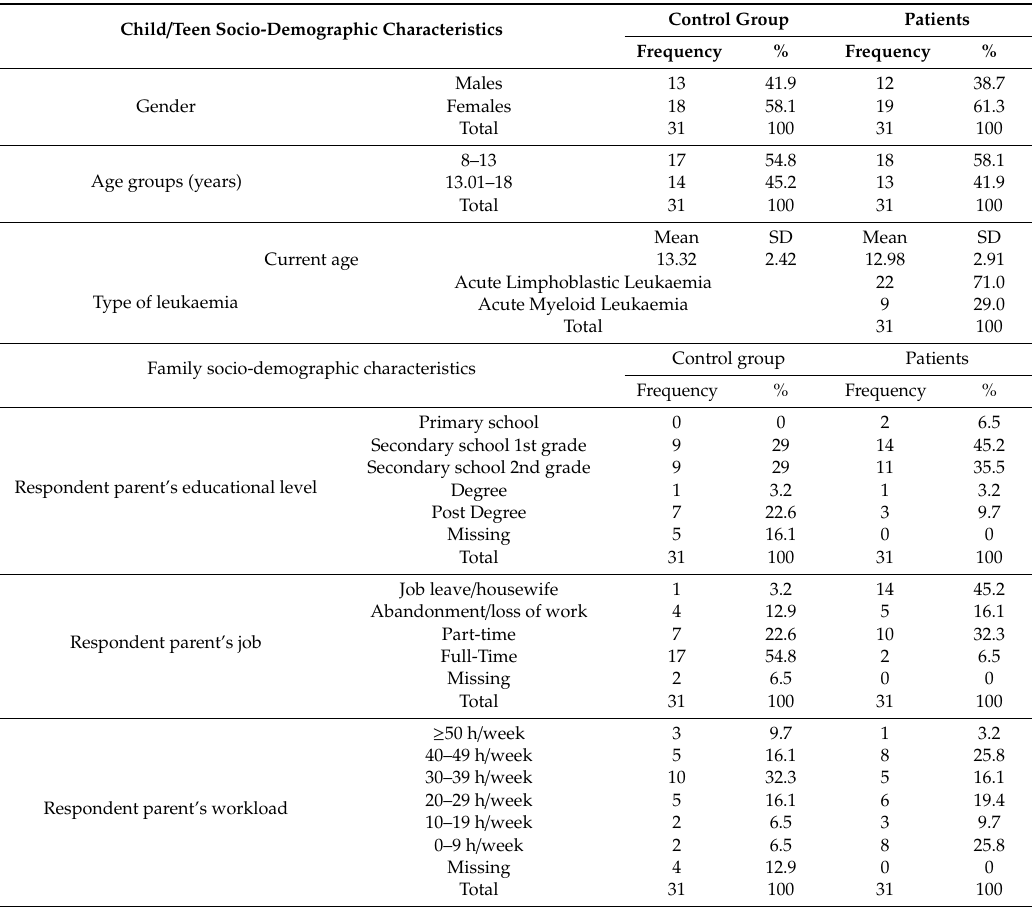
Table 1. Socio-demographic characteristics of patients / families and healthy controls / families at 6 months